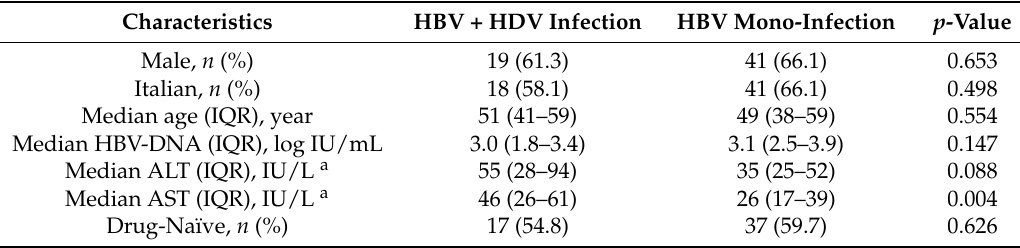
Table 2. Characteristics of 31 HBV + HDV infected and 62 HBV mono-infected patients. Characteristics